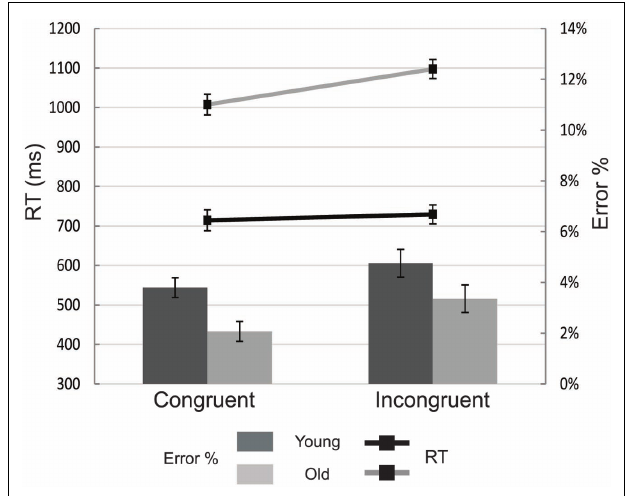
FIGURE 5 | Mean manual reaction times (RT; line graph) and error rates (bar graph) for each of the experimental conditions. Young subjects are depicted with black lines and dark-gray bars. Old subjects are depicted with light gray lines and bars. Error bars represent the